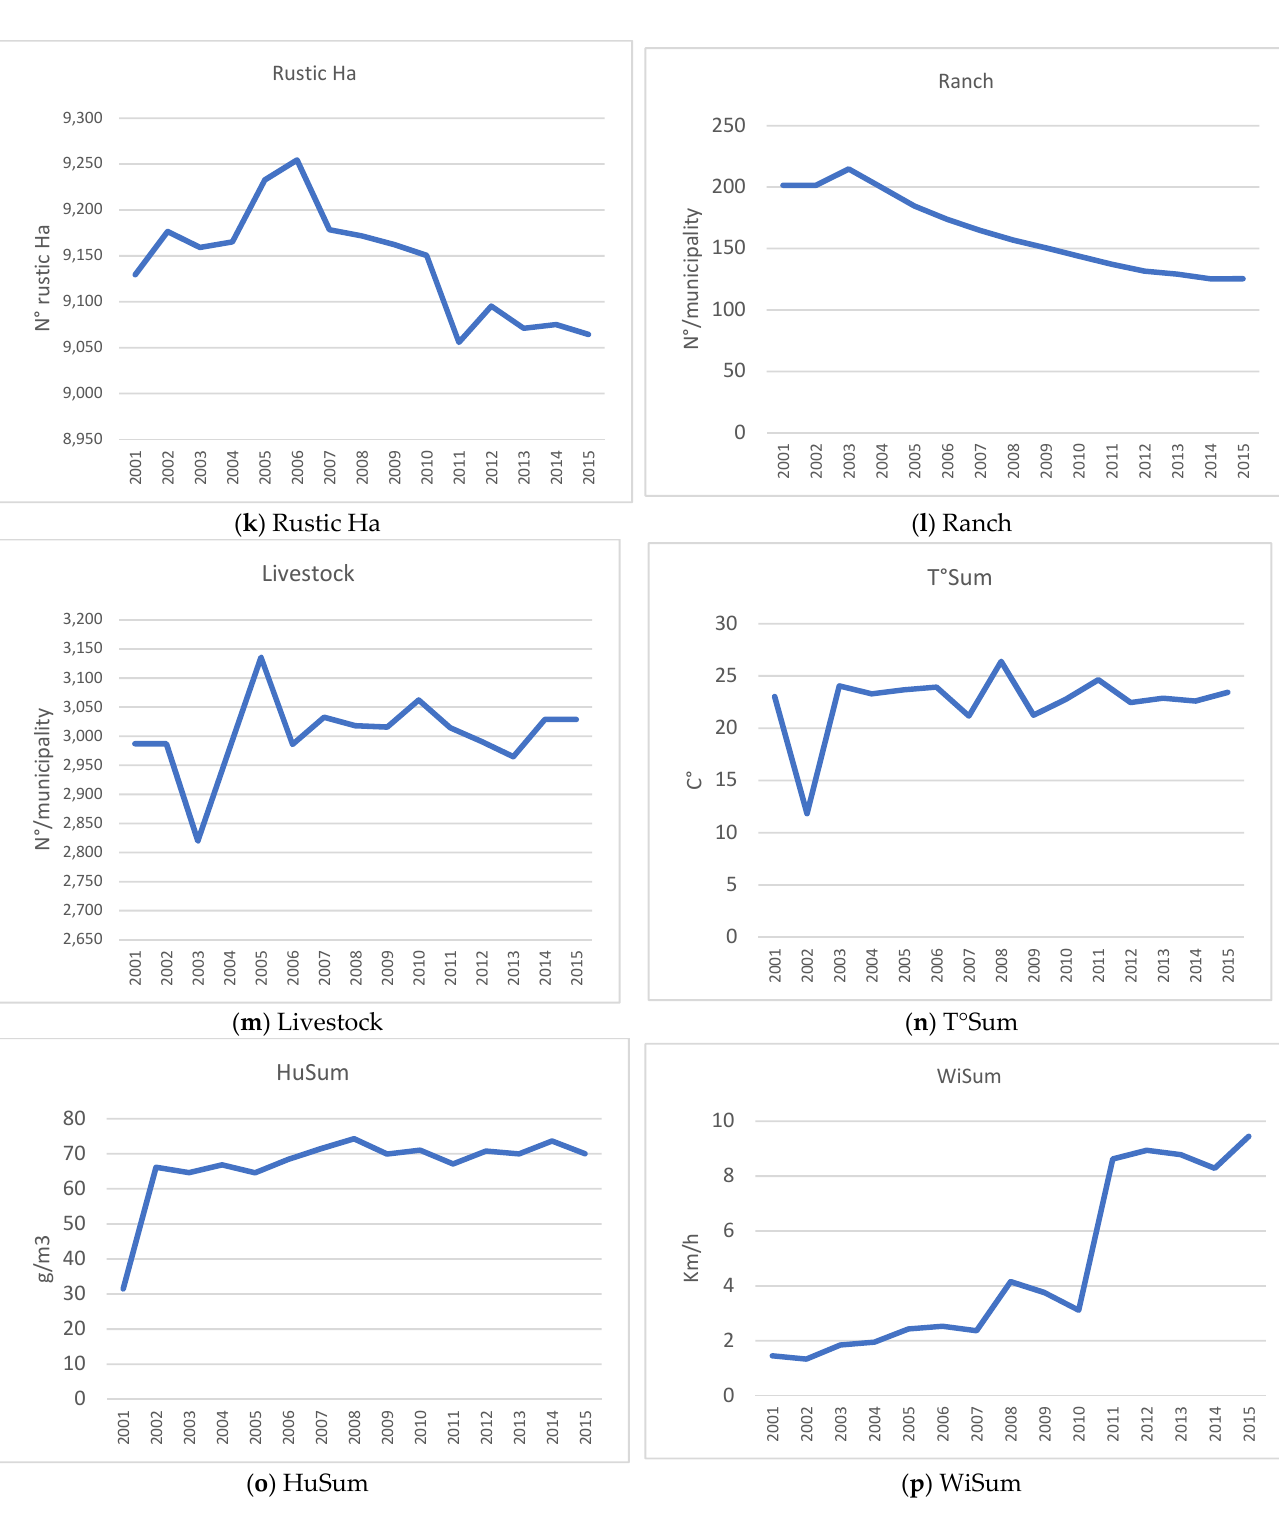
Figure 2. Time evolution of the variables selected between 2001 and 2015 in the Galicia region. Source: IGE (Galician Institute of Statistics).